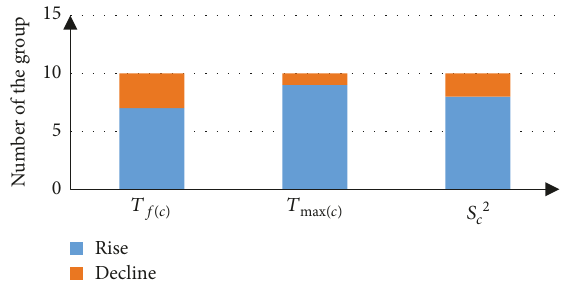
Figure 7: Feature parameters ’ variation in the severe fault